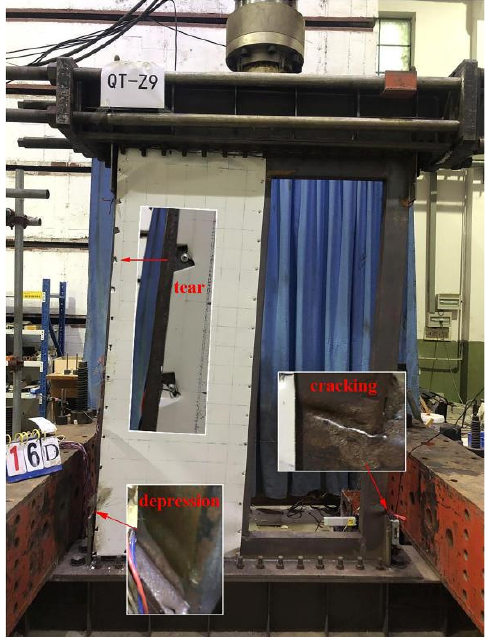
Figure 13. Failure image of QT–Z9.